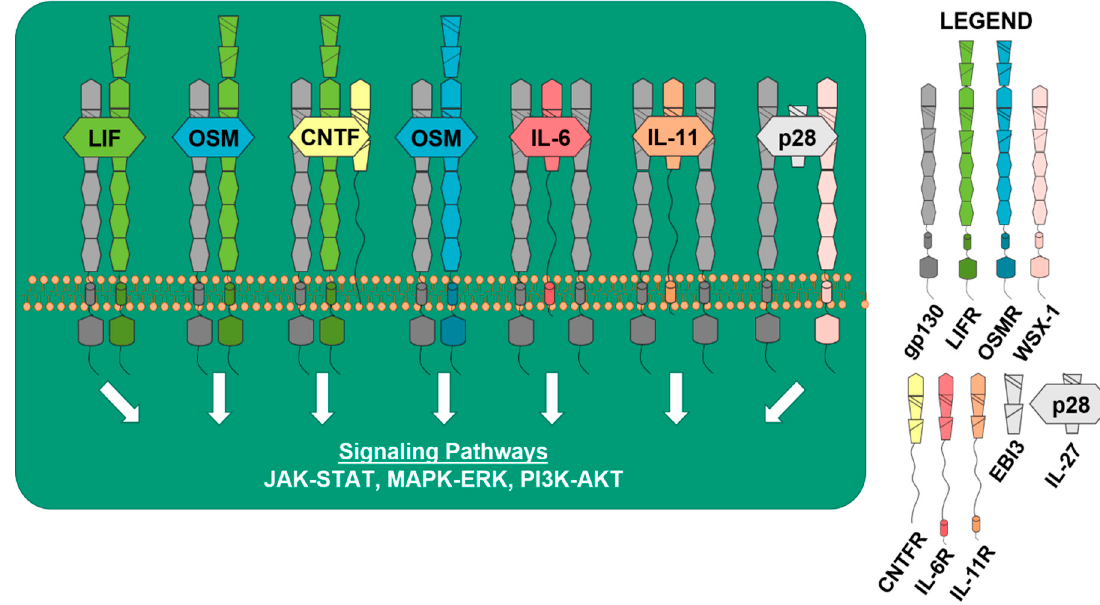
Figure 1. gp130 cytokines and receptors activate downstream signaling pathways. Receptors: dark gray = glycoprotein130 (gp130) co-receptor, green = leukemia inhibitory factor (LIF) receptor (LIFR), blue = oncostatin M (OSM) receptor (OSMR), light pink = WSX-1 (interleukin 27 receptor subunit alpha), yellow = ciliary neurotrophic factor (CNTF) receptor (CNTFR), dark pink = interleukin-6 (IL-6) receptor (IL-6R), orange = interleukin-11 (IL-11) receptor (IL-11R), light gray = Epstein-Barr virus induced 3 (EBI3), and EBI3 + IL-27p28 (IL-30) = interleukin-27 (IL-27). LIF, OSM, CNTF, IL-6, Il-11, and IL-27 bind to their cytokine-specific receptors to activate major downstream signaling pathways: the Janus-activated kinase (JAK)–signal transducer and activator of transcription (STAT) pathway, the Ras-Raf mitogen-activated protein kinase (MAPK and MEK / ERK) signaling cascade, and the phosphatidylinositol 3-kinase-dependent (PI3K / AKT) pathway.